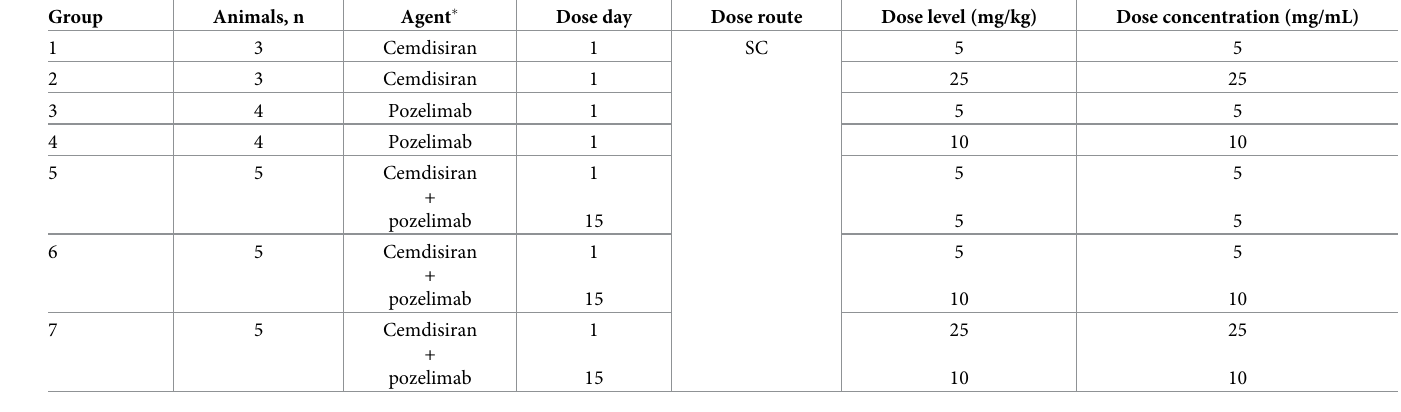
SC, subcutaneous. � Administered as a single SC